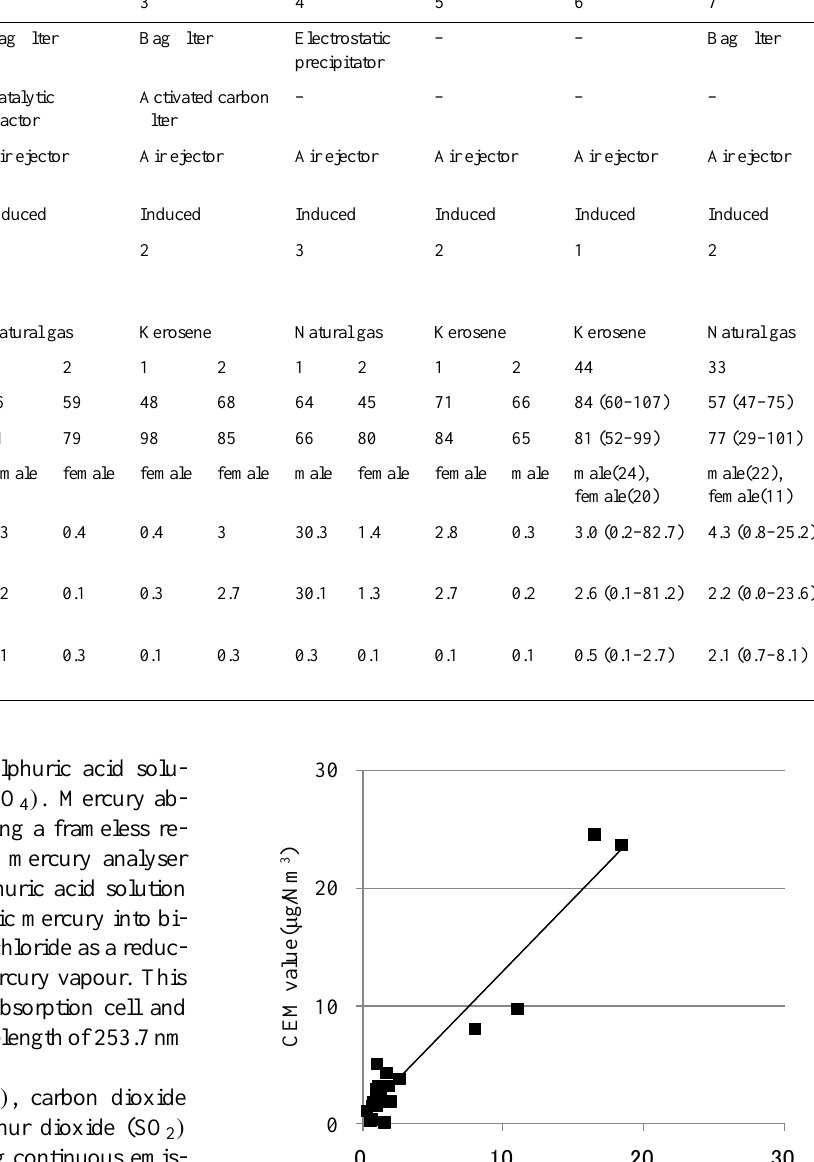
Table 1. The configurations and mercury concentration of seven crematories. Facility No.